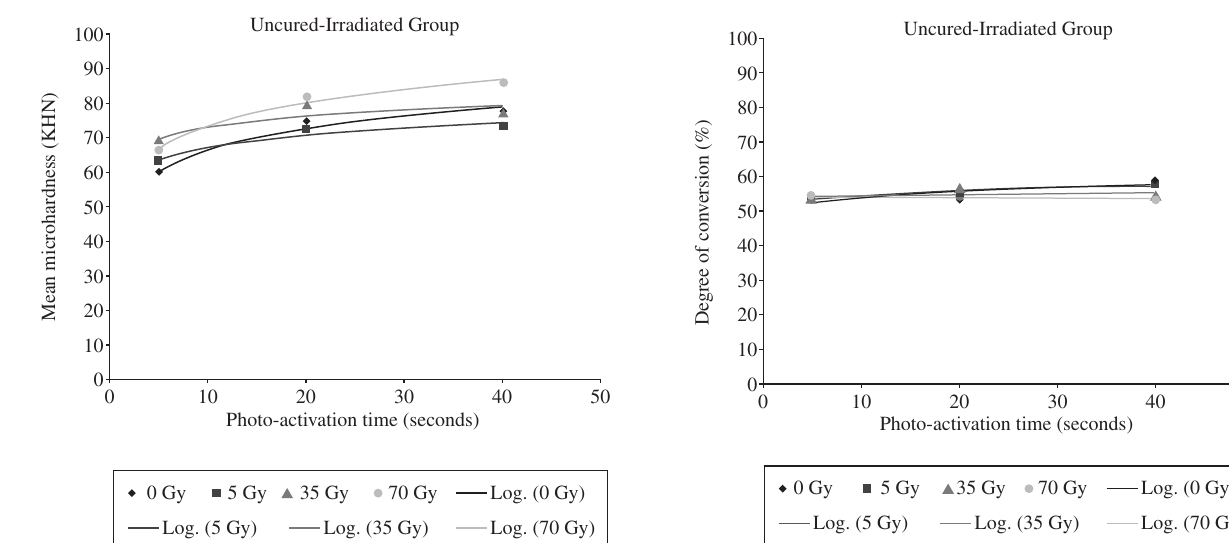
Figure 2. Regression analysis of microhardness averages of the Filtek Z250 TM material to uncured-irradiated groups in accordance with radiation dose as a function of the photo-activation time.